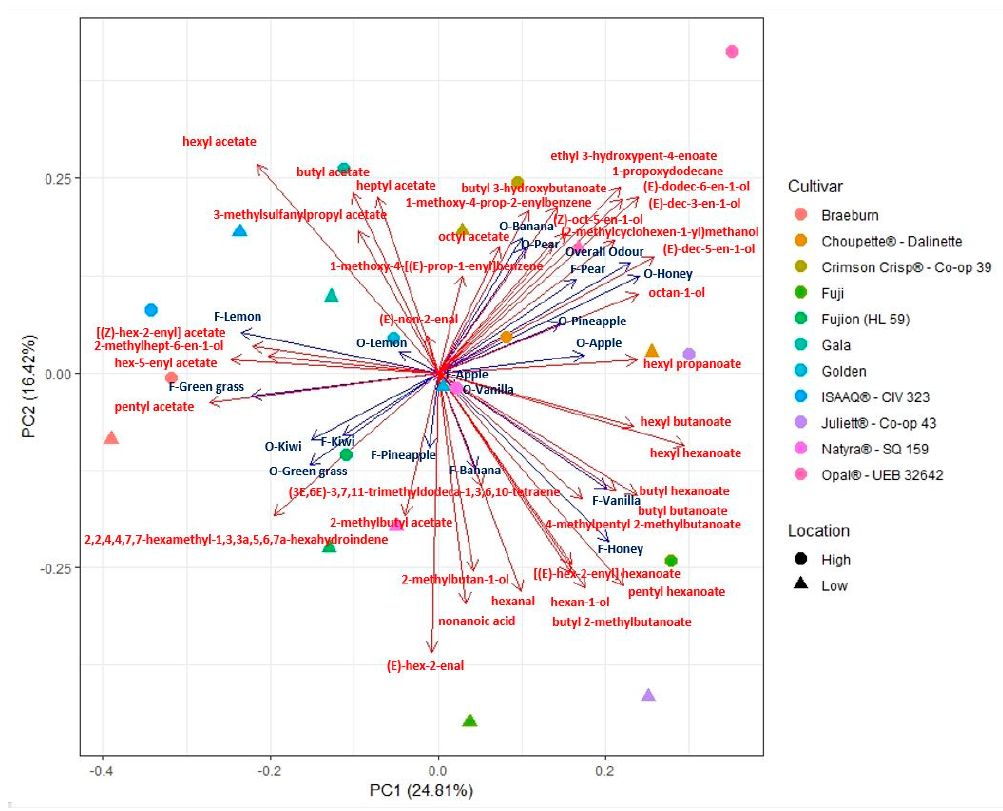
Figure 2. Principal component analysis reporting VOCs (red) and sensory parameters (blue) together. Varieties are reported with different colors and different shapes for low (225 m) and high (650 m) pedoclimatic locations.